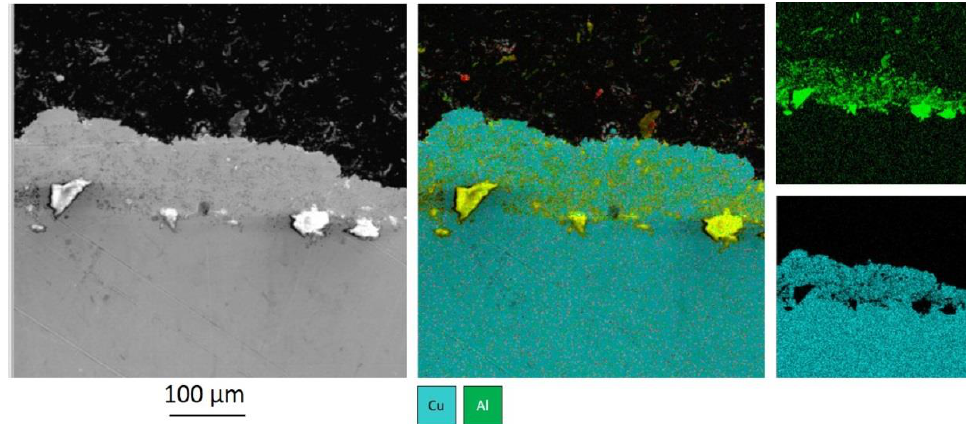
cold-sprayed 40% Cu-60% Al 2 O 3 without preprocessing.